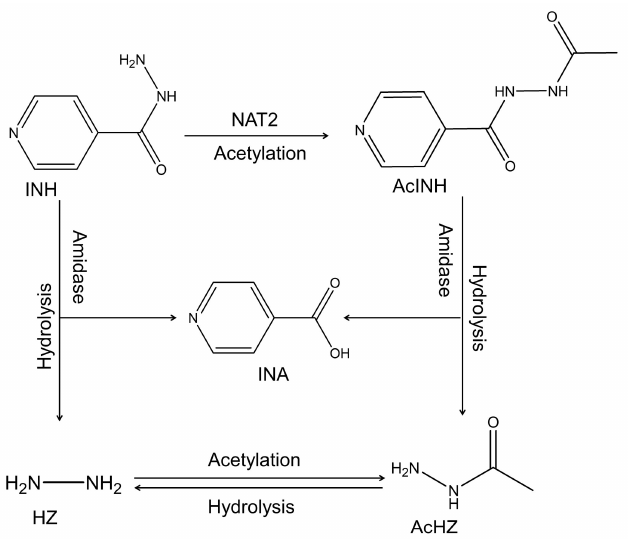
Figure 1. Chemical structures and metabolic pathway of INH and metabolites. Compounds that are quantified in this study are INH, AcINH, INA, HZ, and AcHZ. Abbreviations: INH, isoniazid; AcINH, acetylisoniazid; INA, isonicotinic acid; HZ, hydrazine; AcHZ, acetylhydrazine; NAT2, N -